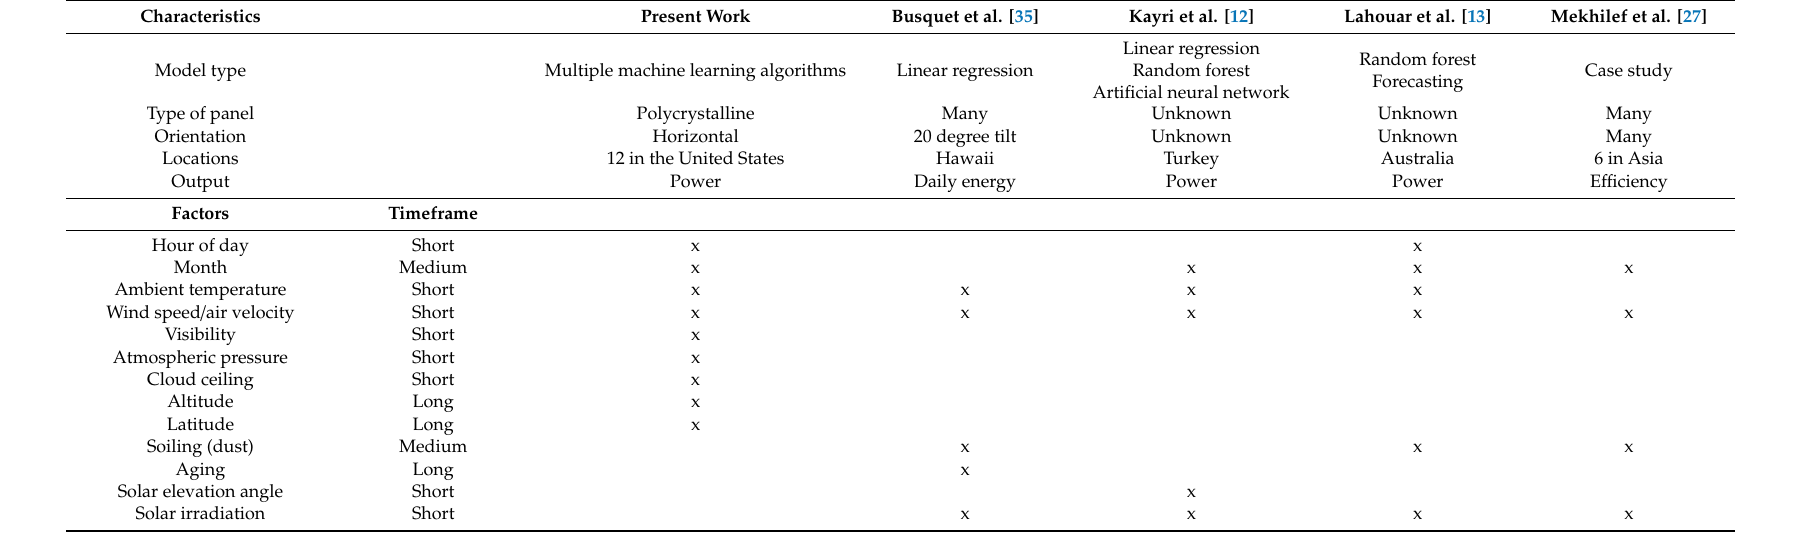
Table 1. Comparison of independent